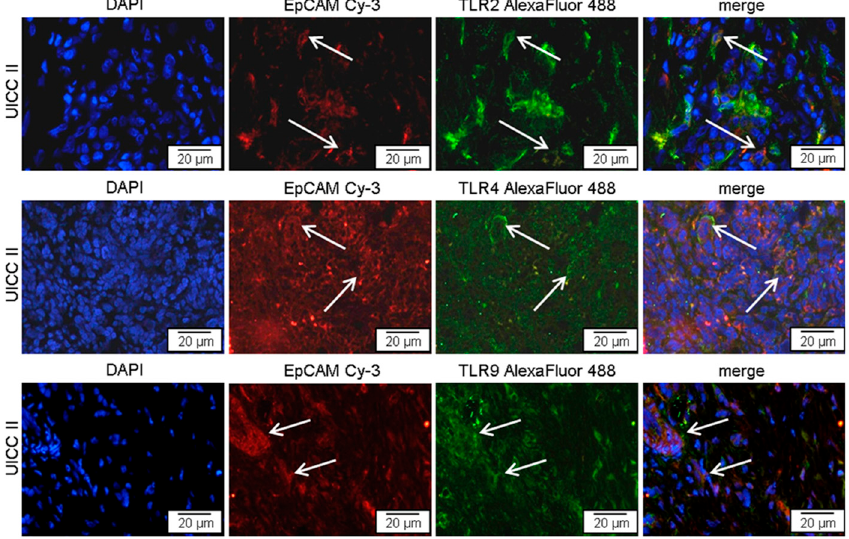
Figure 2. TLR2, -4, or -9 expressing tumor cells in pancreatic cancer tissue. Representative examples of immunofluorescence double staining, showing TLR (green) and EpCAM (red) co-staining (arrows) in tumor cells of patients with pancreatic cancer UICC II. AlexaFluor 488, green; Cy3 (indocarbocyanin), red; DAPI (49,6-diamidino-2-phenylindoldihydrochlorid), blue—nuclear